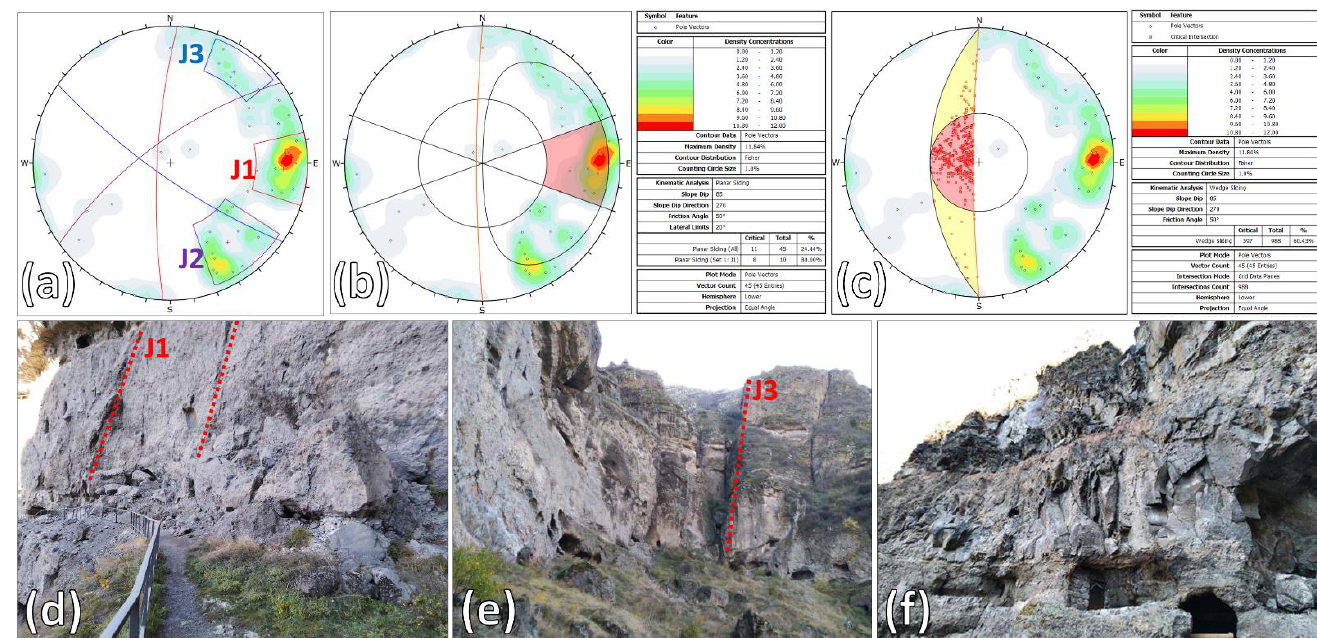
Figure 6. Structural setting and kinematic analysis at Vanis Kvabebi: identified sets ( a ); kinematic analysis for planar ( b ) and wedge ( c ) failures; 2017 rock fall deposits ( d ); subvertical fracture where creek channel erosion has concentrated ( e ); welded tuff portion affected by wedge failures ( f ).